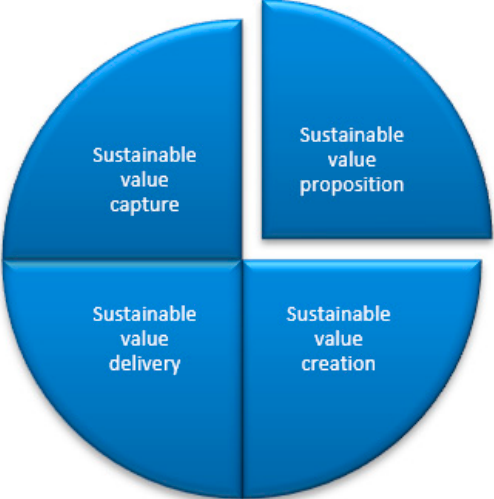
Figure 3. Sustainable Business Model components. The figure was created using Microsoft ® Word for Microsoft 365 MSO.